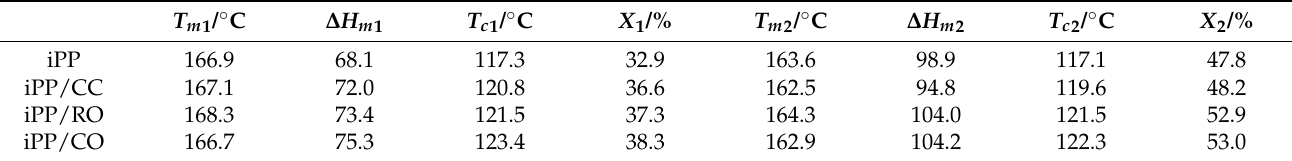
Table 1. Thermal parameters of neat iPP and its composites obtained from